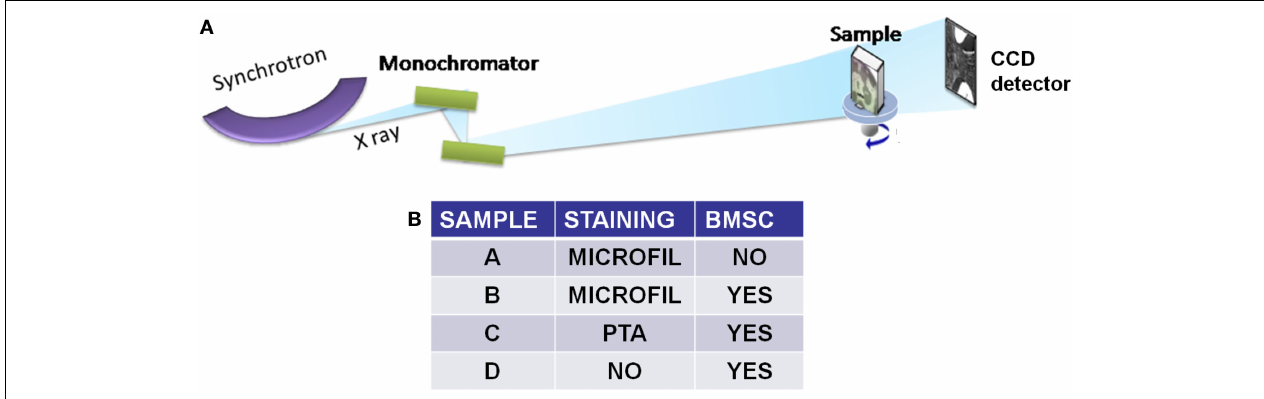
FIGURE 1 | (A) Pictorial view of the experimental configurations used for XRPC μ T measurements. The in-line, or propagation based, phase-contrast experimental setup, installed at the SLS synchrotron at PSI in Switzerland. (B) The table summarizes the characteristics of the different investigated